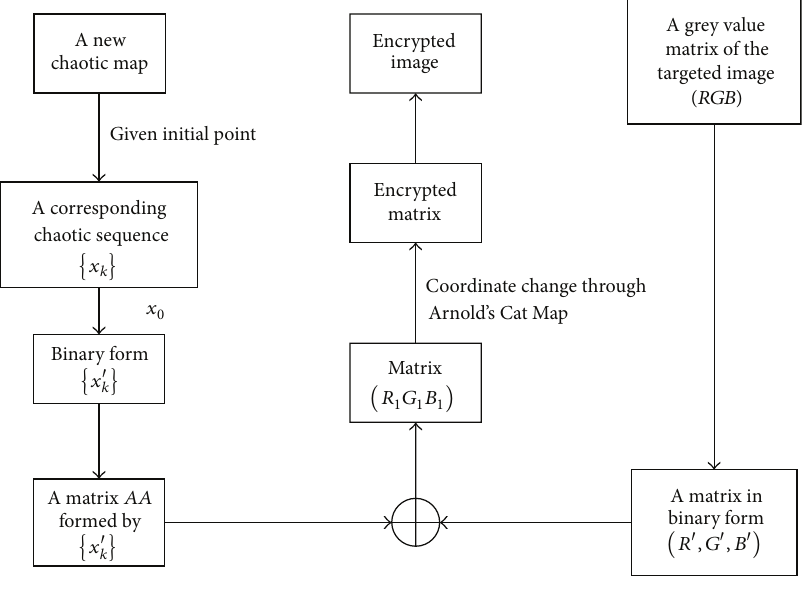
Figure 7: Proposed encryption